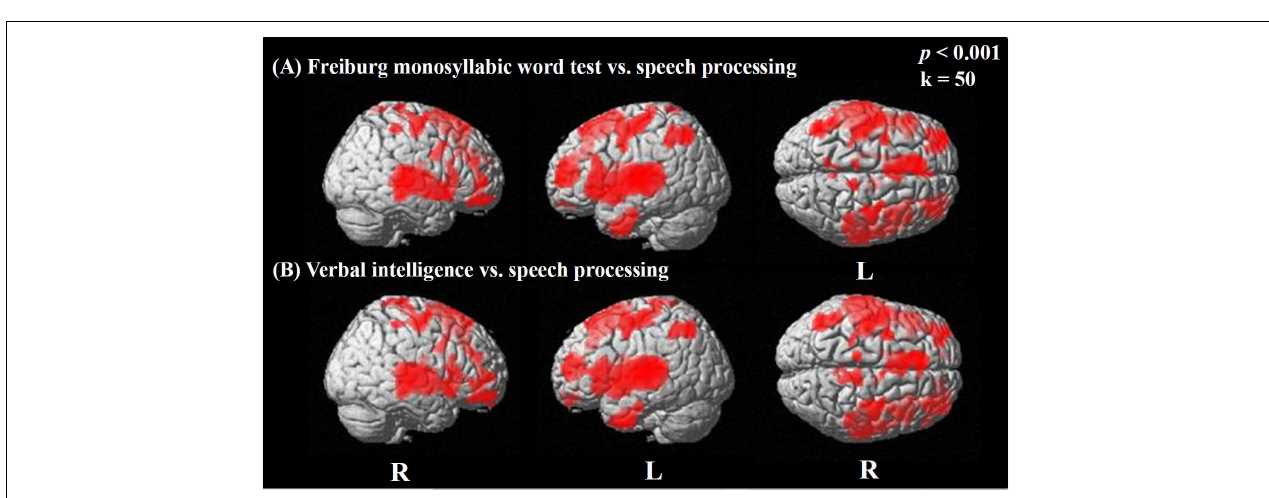
FIGURE 5 | Statistical parametric maps (SPMs) reflecting correlations between activation during the speech-discrimination task (semantic-anomaly paradigm) and the result of the Freiburg monosyllabic word test (speech recognition; A ) and the MWT-B (verbal intelligence; B ), respectively. SPMs are overlaid to a surface rendered MRI data set in the Montreal Neurological Institute (MNI) space. There are some areas displaying more transparency than others, which refers to their distance to the projection surface. Note the extended activation of bilateral areas in temporal, frontal, and parietal cortices, showing significant relationships with speech processing (during task) and verbal